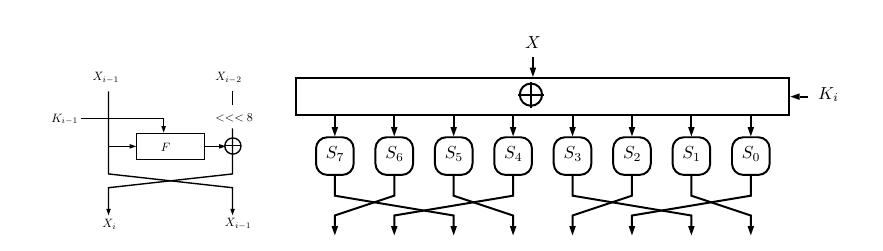
Figure 2: High-level description of one round of LBlock (left) and description of the F function (right).